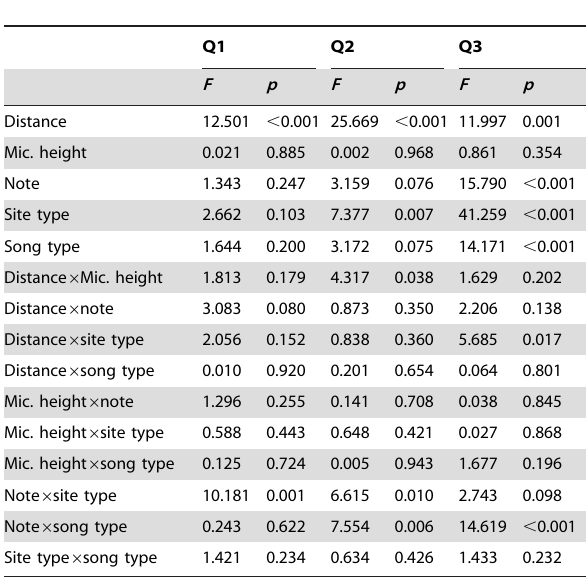
Table 4. Factorial ANOVA table of experiment 2 showing the main effects and two-way interactions of all the variables three quartiles of tail energy decline.